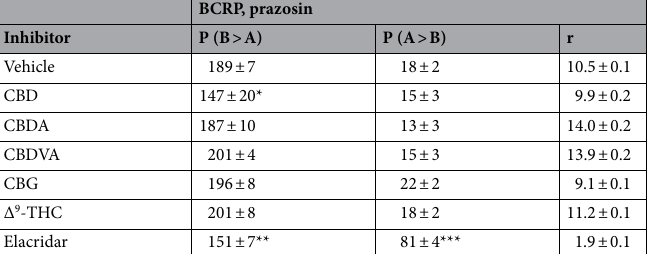
Table 4. Permeability of prazosin in the presence of cannabinoids. P Permeability calculations (× 10 −2 cm/s). n.d. not determined; slope of concentration–time curve was not significantly different from zero. * p < 0.05, ** p < 0.005, *** p < 0.0005 compared to corresponding vehicle